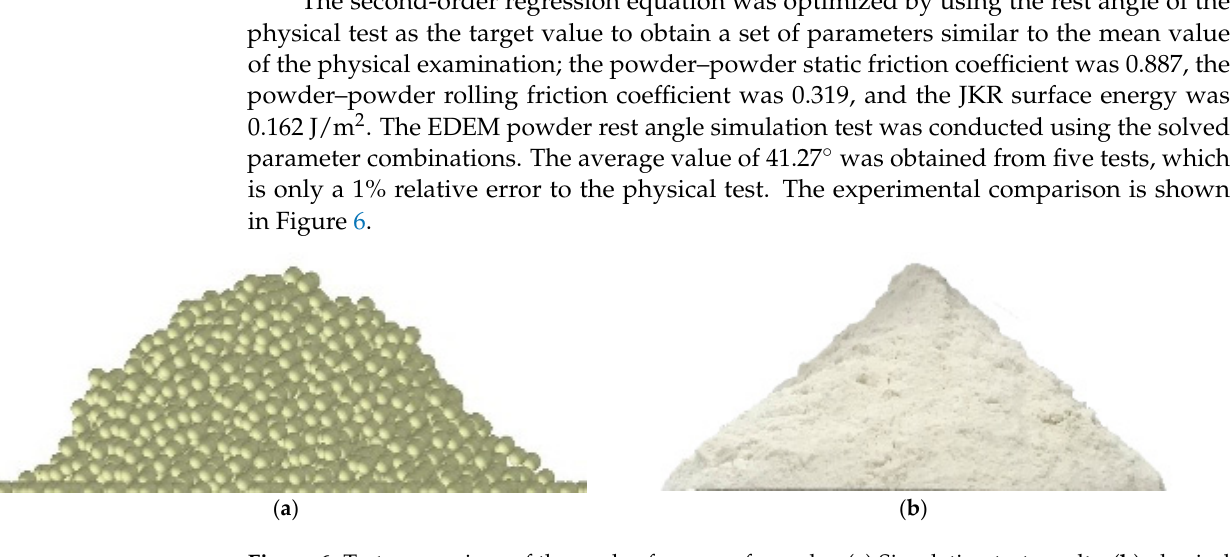
Figure 6. Test comparison of the angle of repose of powder. ( a ) Simulation test results; ( b ) physical test results.